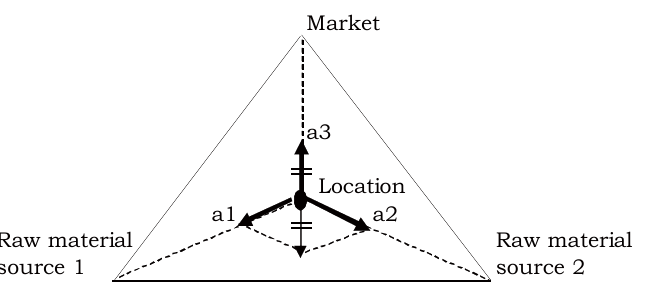
Figure 1. Location by minimizing transportation cost Note : a1 ― Pulling force to “raw material source